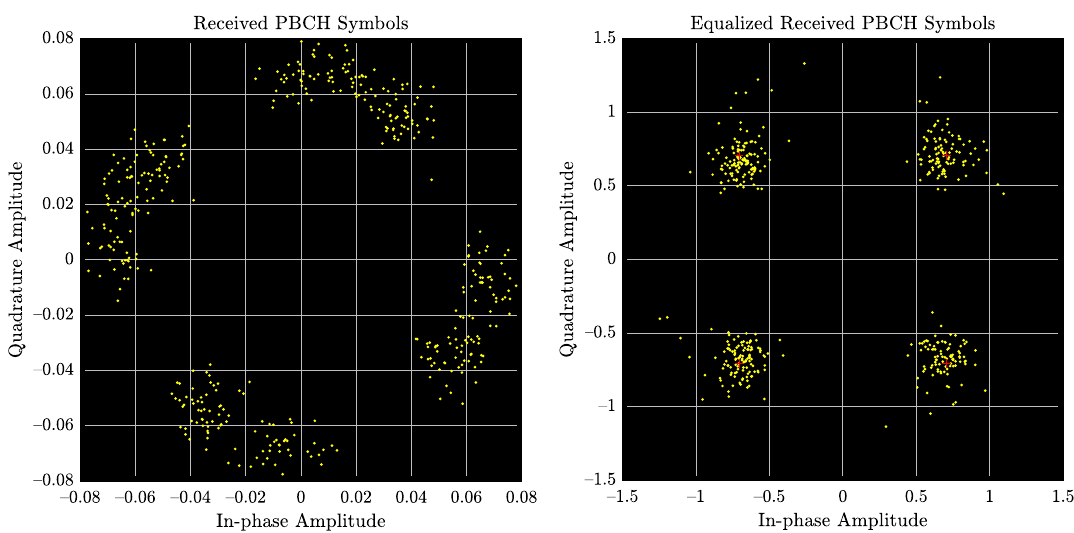
Figure 11. Received PBCH and equalized received PBCH constellation diagrams.